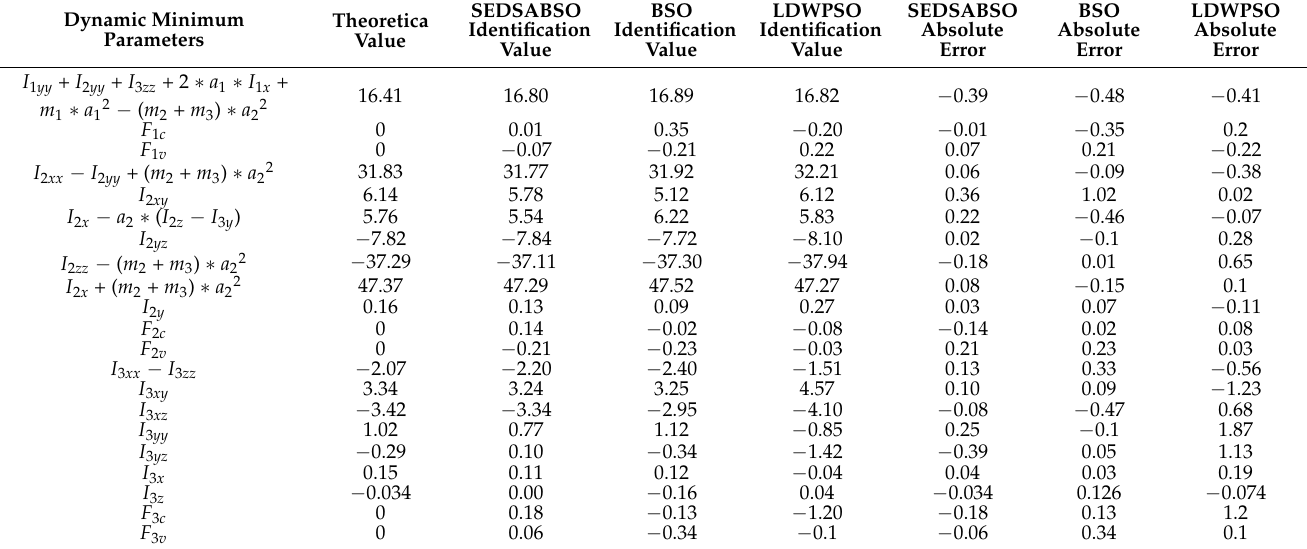
Table 5. Identification of dynamic